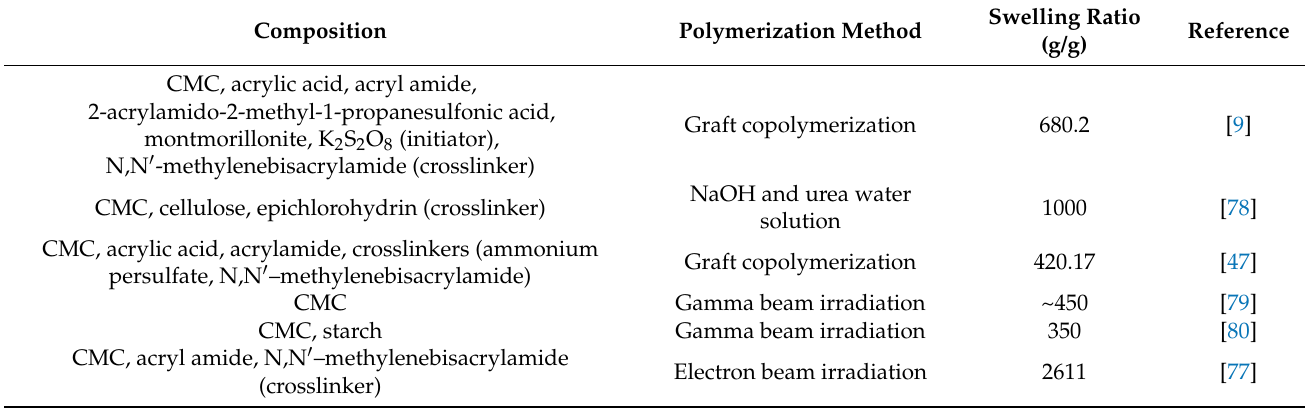
Table 2. Superabsorbent hydrogels containing carboxymethyl cellulose in their composition.